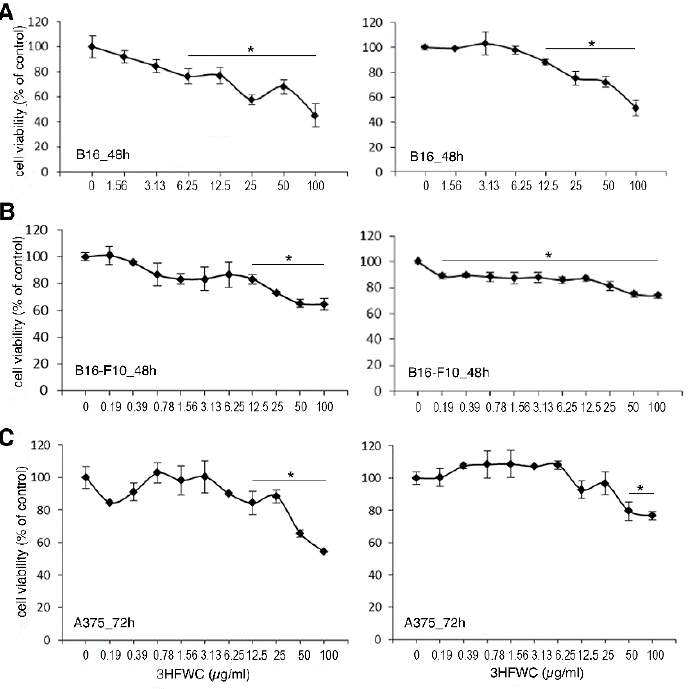
Figure 1. Inhibition of melanoma cell viability by hyper-harmonized hydroxylated fullerene water complex (3HFWC) and hyperpolarized light (HPL) in vitro. ( A ) B16, ( B ) B16-F10 and ( C ) A375 cells were treated with the indicated dose range of 3HFWC (measured as µ g/mL of fullerol) and with HPL, for 15 min. The viability was evaluated by MTT (left panel) and crystal violet (CV) (right panel) assays. The results after 48 h ( A , B ) and after 72 h of incubation ( C ) are shown. * Significant if p < 0.05 in comparison to untreated